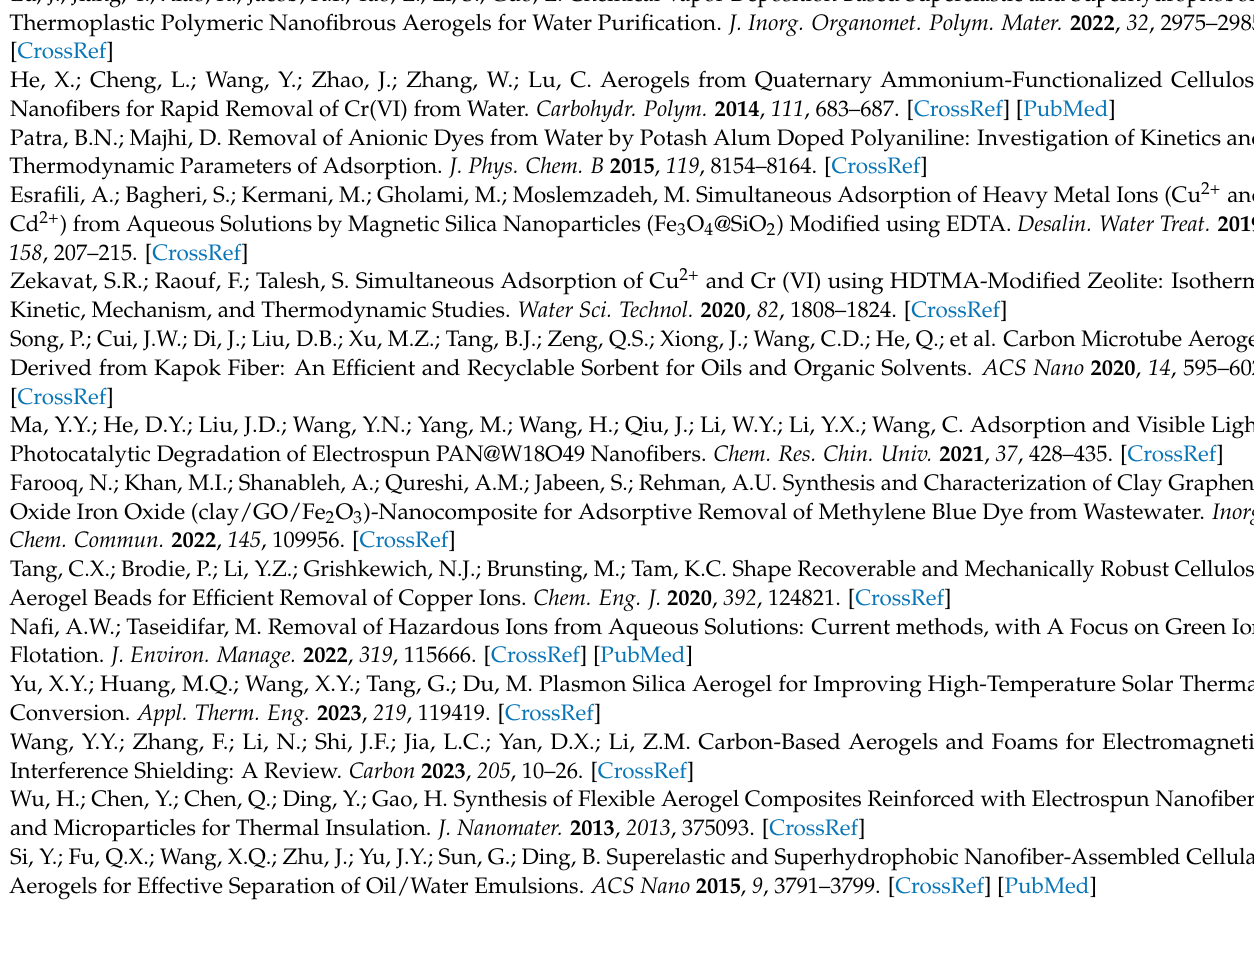
Figure S2: Photograph of EVOH/PANI composite NFAs; Figure S3: photographs of EP-1 under a compression and release ( ε = 80%); Figure S4: The mechanism of dyes adsorption; Figure S5: The adsorption capacity of EP-3 for methyl orange under different